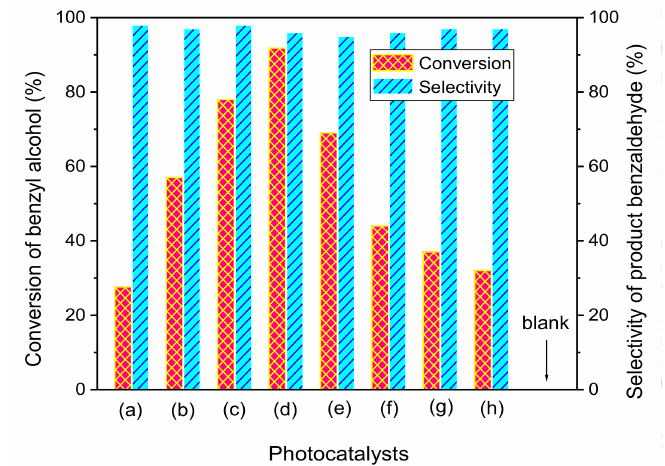
Figure 7. The selective oxidation of benzyl alcohol over HTT/graphene nanocomposites under visible light irradiation: (a) pure HTT, (b) HTT/graphene-0.2%, (c) HTT/graphene-0.4%, (d) HTT/graphene- 1.0%, (e) HTT/graphene-2.0%, (f) HTT/graphene-4.0%, (g) P25 TiO 2 /graphene-1.0%, and (h) HTT/graphene-1.0%-mixed. The blank column represents the experimental results in the absence of visible irradiation or